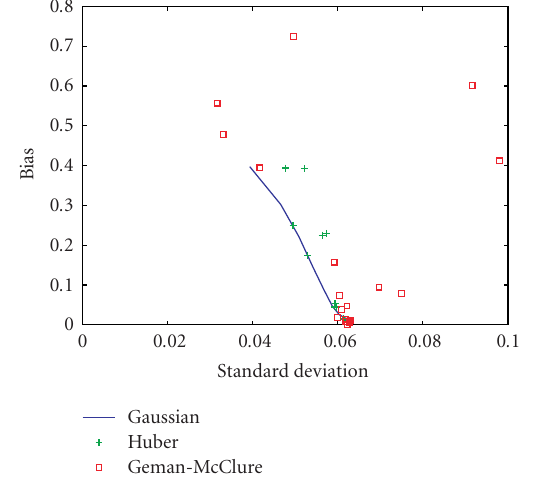
Figure 9: The bias versus standard deviation tradeo ff for quantifi- cation of the large hot region (“bladder”) in Figure